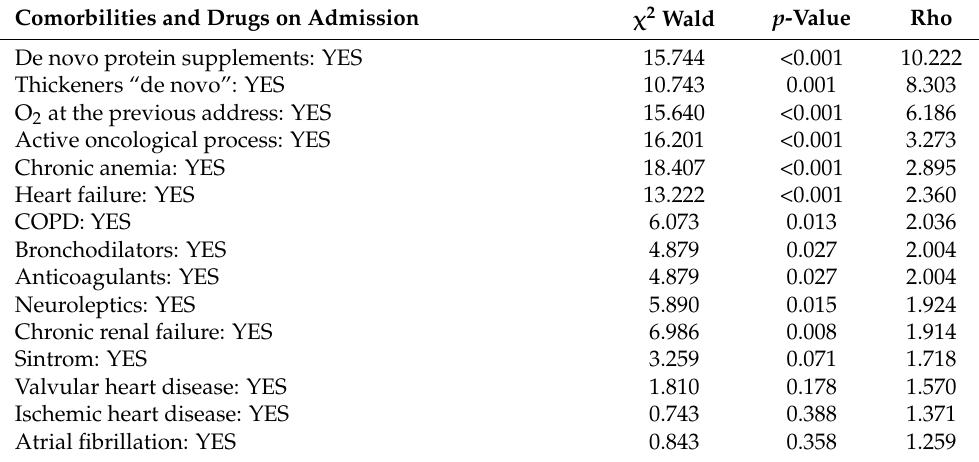
Table 5. Results of binary logistic regression to estimate the relationship between mortality at sixth month and comorbidities and drugs at admission.